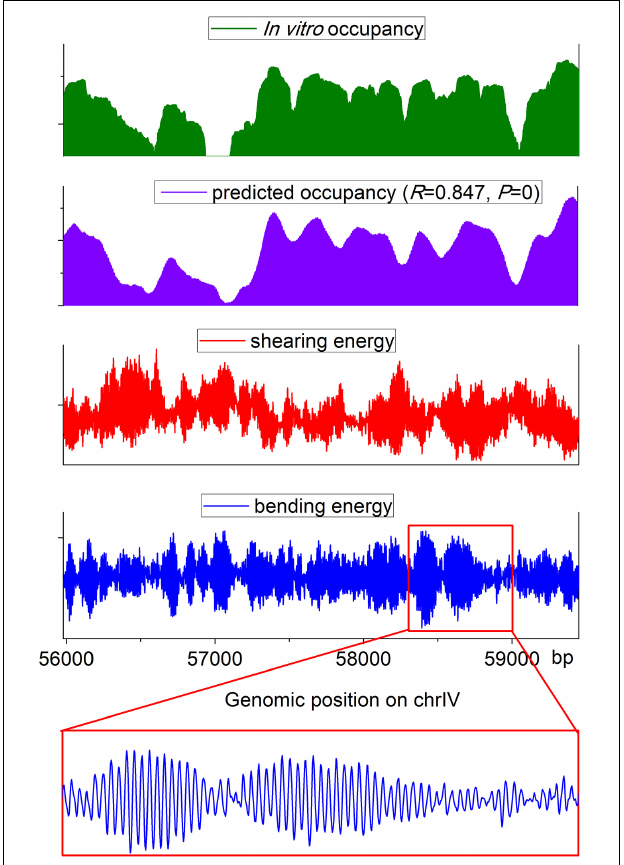
FIGURE 2 | Landscape of estimated nucleosome occupancy, experimental nucleosome occupancy (Kaplan et al., 2009), and corresponding bending energy and shearing energy for a genomic region in budding yeast. The estimated occupancy shows a good agreement with the experimental map. Shearing energy was negatively correlated with the nucleosome occupancy, and the 10-bp oscillated bending energy profile can indicate the rotational positioning of a